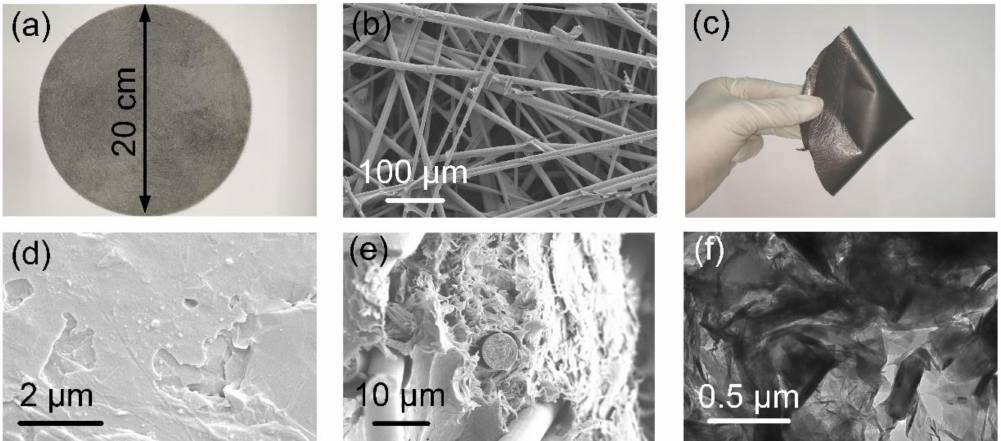
Figure 2. ( a ) Macroscopic and ( b ) microscopic morphology of a flexible and robust carbon fabric. ( c ) Folding the CFG film shows its flexibility. ( d ) Surface morphology and ( e ) cross-section morphology of the CFG film. ( f ) Transmission electron microscopy of ultrathin slices of the CFG